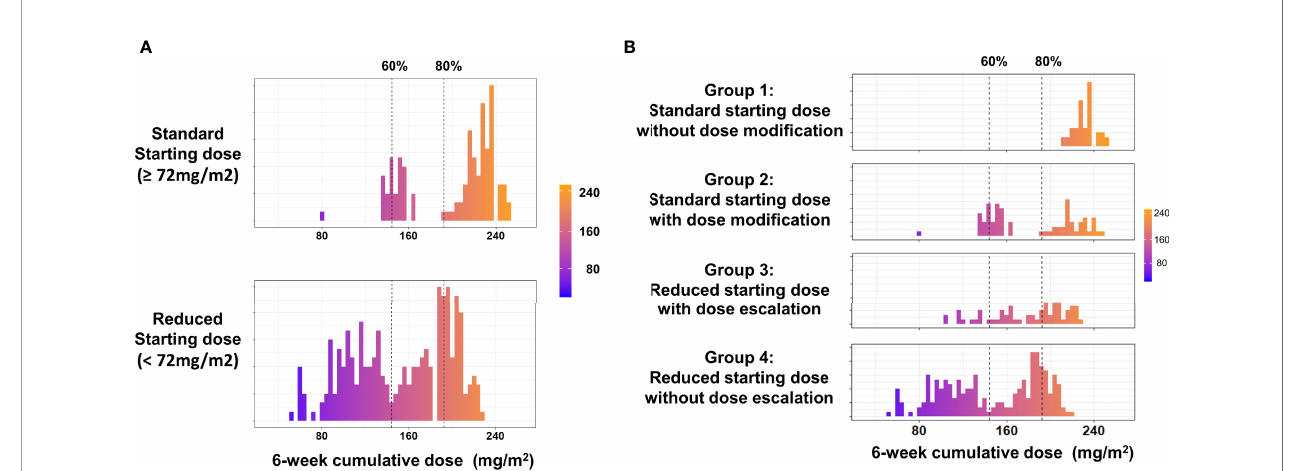
FIGURE 3 | (A) Distribution of the 6-week cumulative dose in the standard and reduced starting dose groups. (B) Distribution of the 6-week cumulative dose in the different dosing pattern groups. Only included patients received at least two doses of